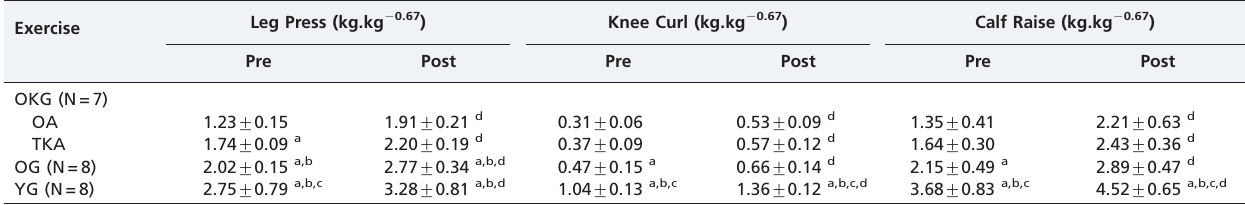
Table 2. 1-repetition maximum strength test before and after 13 weeks of exercise training.